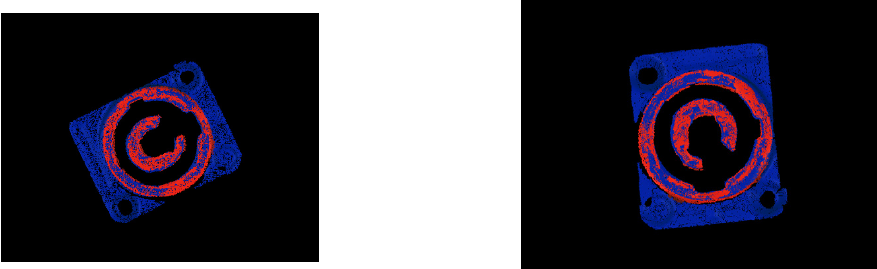
( b ) Figure 18. Neutrik plug depth image andsegmented image: ( a ) Neutrik plug depth image; ( b ) seg- mented image. We used the point cloud registration method proposed in this paper to perform point cloud registration on the segmented point cloud data, and compare the registration results with other methods. The comparison results are shown in Table 2. It can be seen from the table that although the method proposed in this paper takes more time overall than Seget- ICP [30] and BiLuNetICP [31], the registration accuracy is improved. For assembly tasks, the increase in registration accuracy is conducive to the stability of the assembly process, so the method in this paper is valuable and meaningful. Table 2. 6D Pose Estimation Results. Methods Rotation Mean Error (°) Translation Mean Error (mm) Runtime (s) Seget-ICP [30]